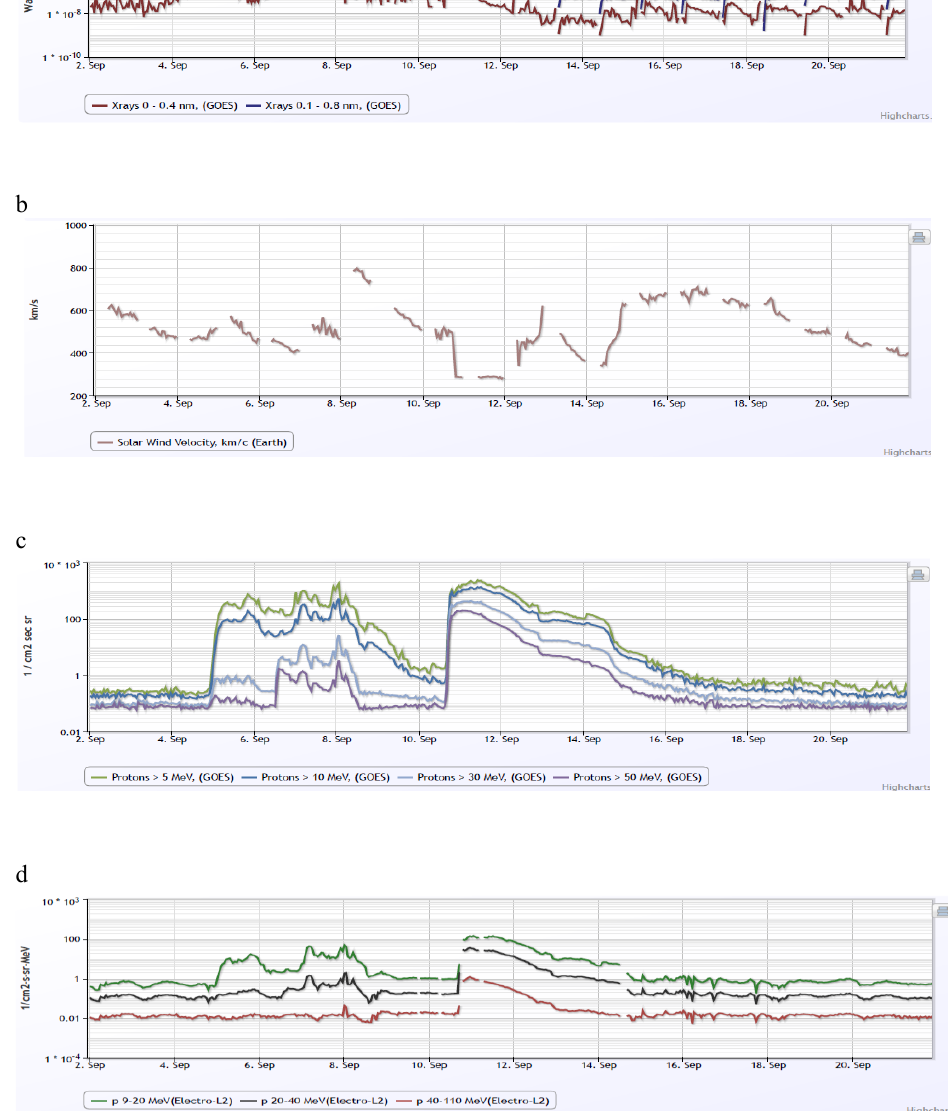
Fig. 6. Time profiles of solar X-ray power (а), SW velocity (b) and solar proton fluxes on the geo-stationary orbit (c, d) 02.09 -